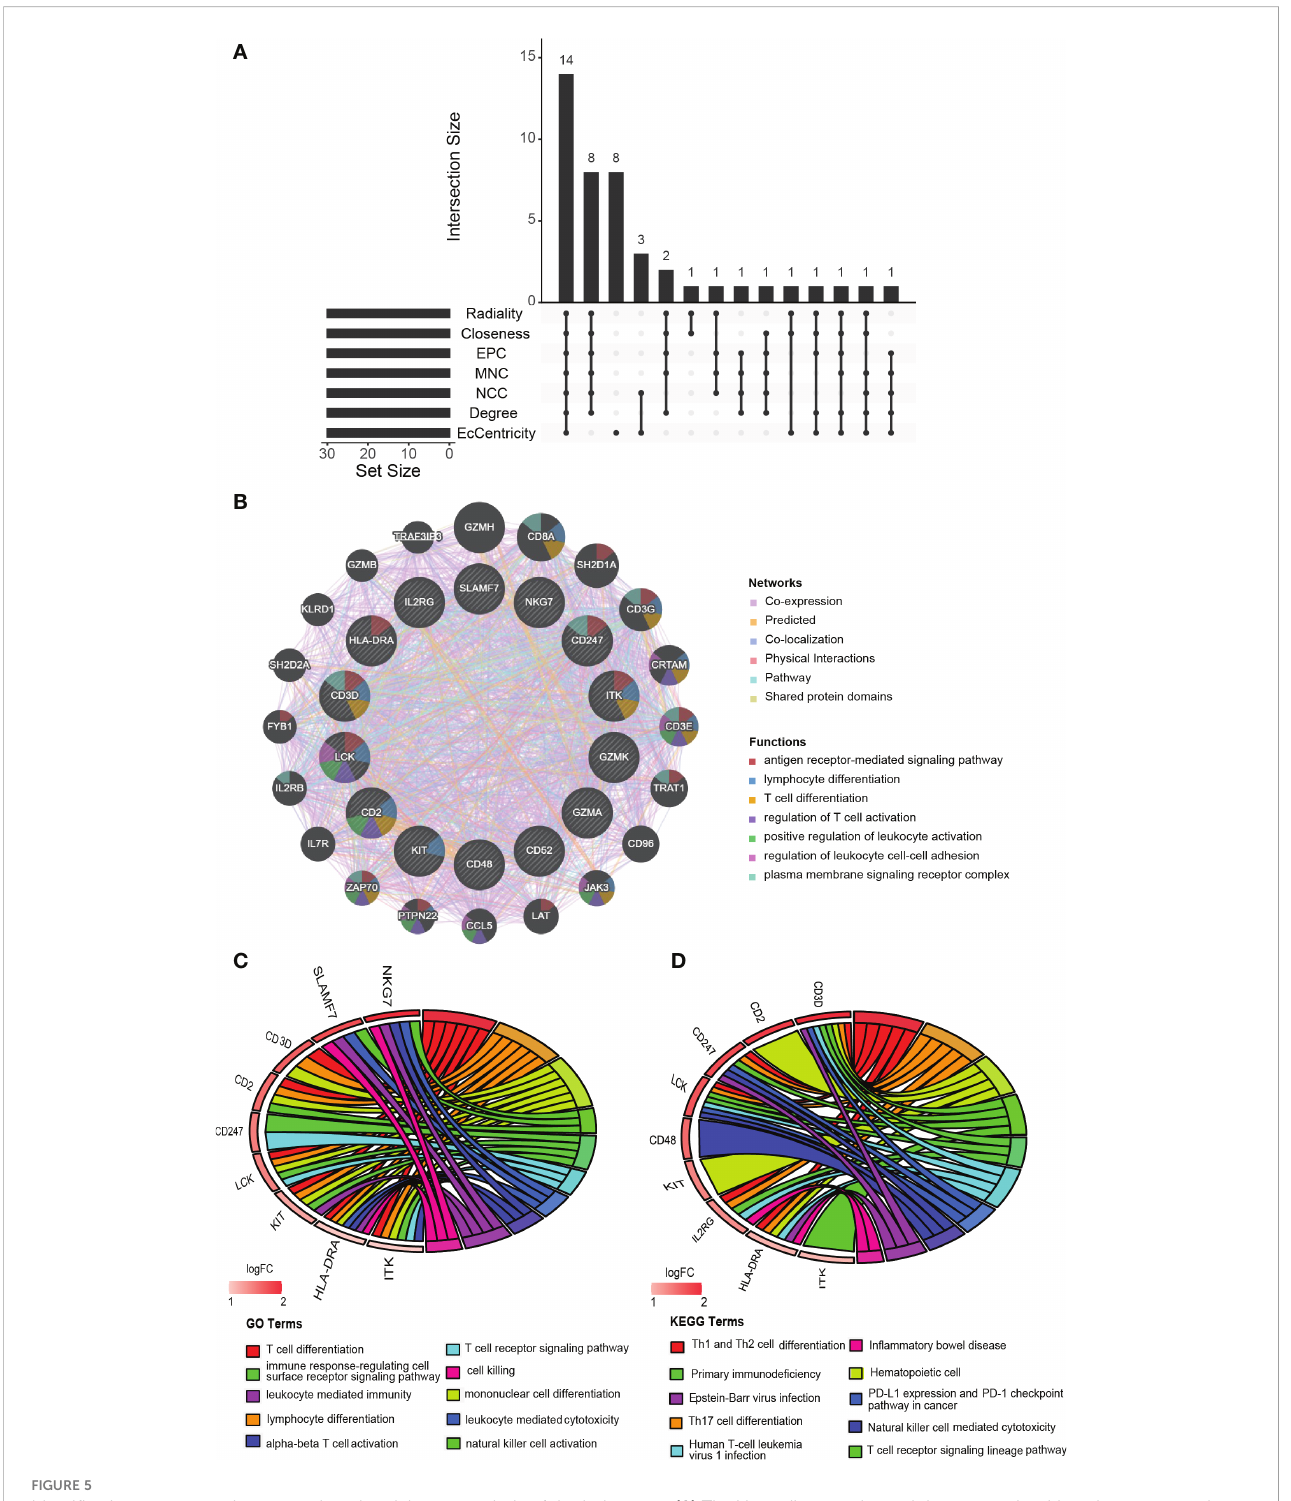
FIGURE 5 Identi fi cation, co-expression network and enrichment analysis of the hub genes. (A) The Venn diagram showed that seven algorithms have screened out 14 overlapping hub genes. (B) Hub genes and their co-expression genes were analyzed via GeneMANIA. (C, D) GO and KEGG enrichment analysis of the hub